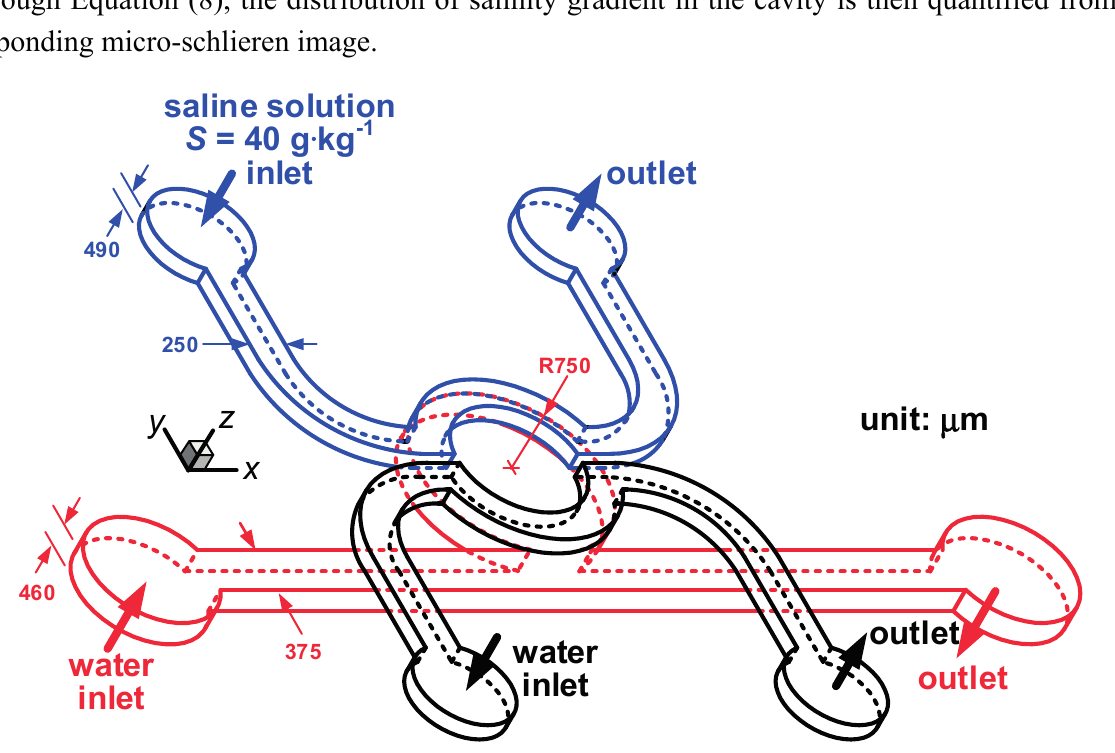
Figure 5. The microfluidic device for studying microbial response to a salinity gradient. The blue and black lines delineate the microchannels for saline solution and water in the top layer, respectively. The red lines outline the cavity-flow microchannel for water in the bottom